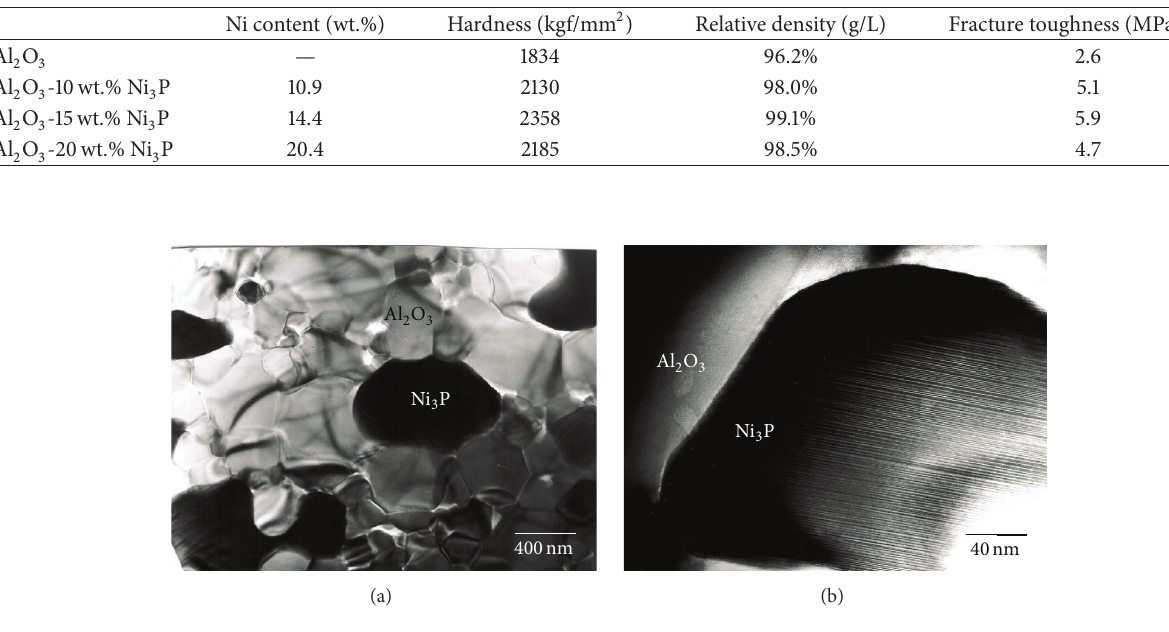
Figure 5: TEM (a) and HRTEM (b) images of hot-pressed Al 2 O 3 -Ni-P composite.